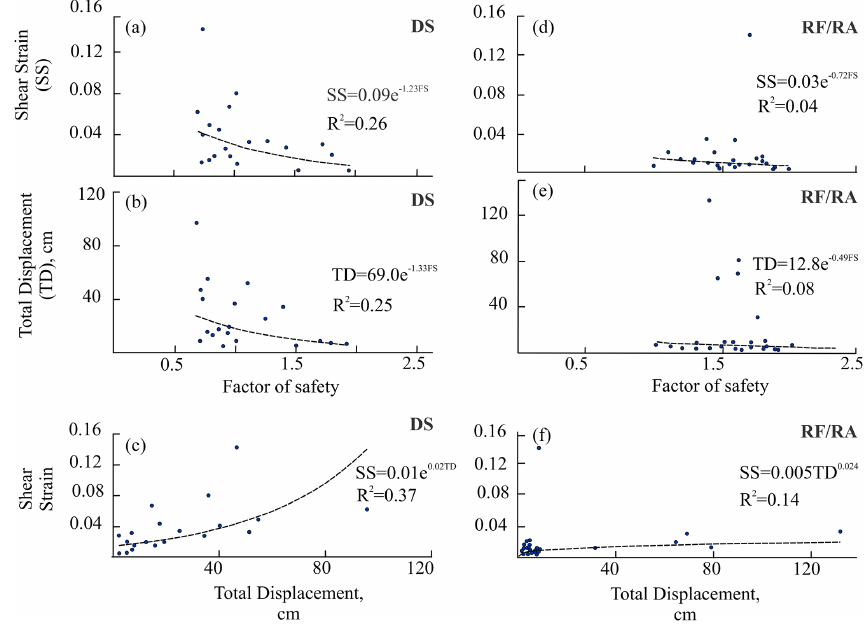
Figure 5. Relationship of factor of safety (FS), total displacement (TD), and shear strain (SS). DS, RF, and RA refer to debris slide, rockfall, and rock avalanche,